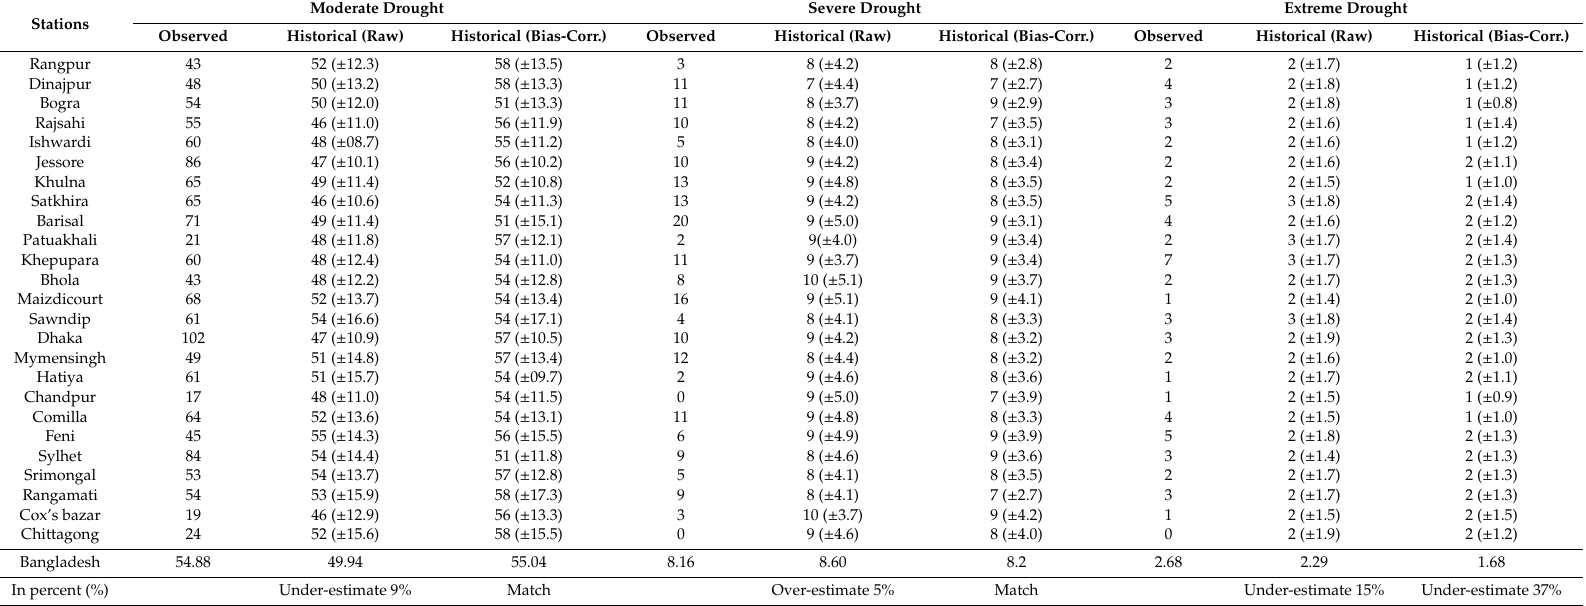
Table 5. Comparison of several drought events calculated from observed precipitation data and raw and bias-corrected GCM data for 1976–2005. Values in parentheses refer to the standard deviation of the results over the